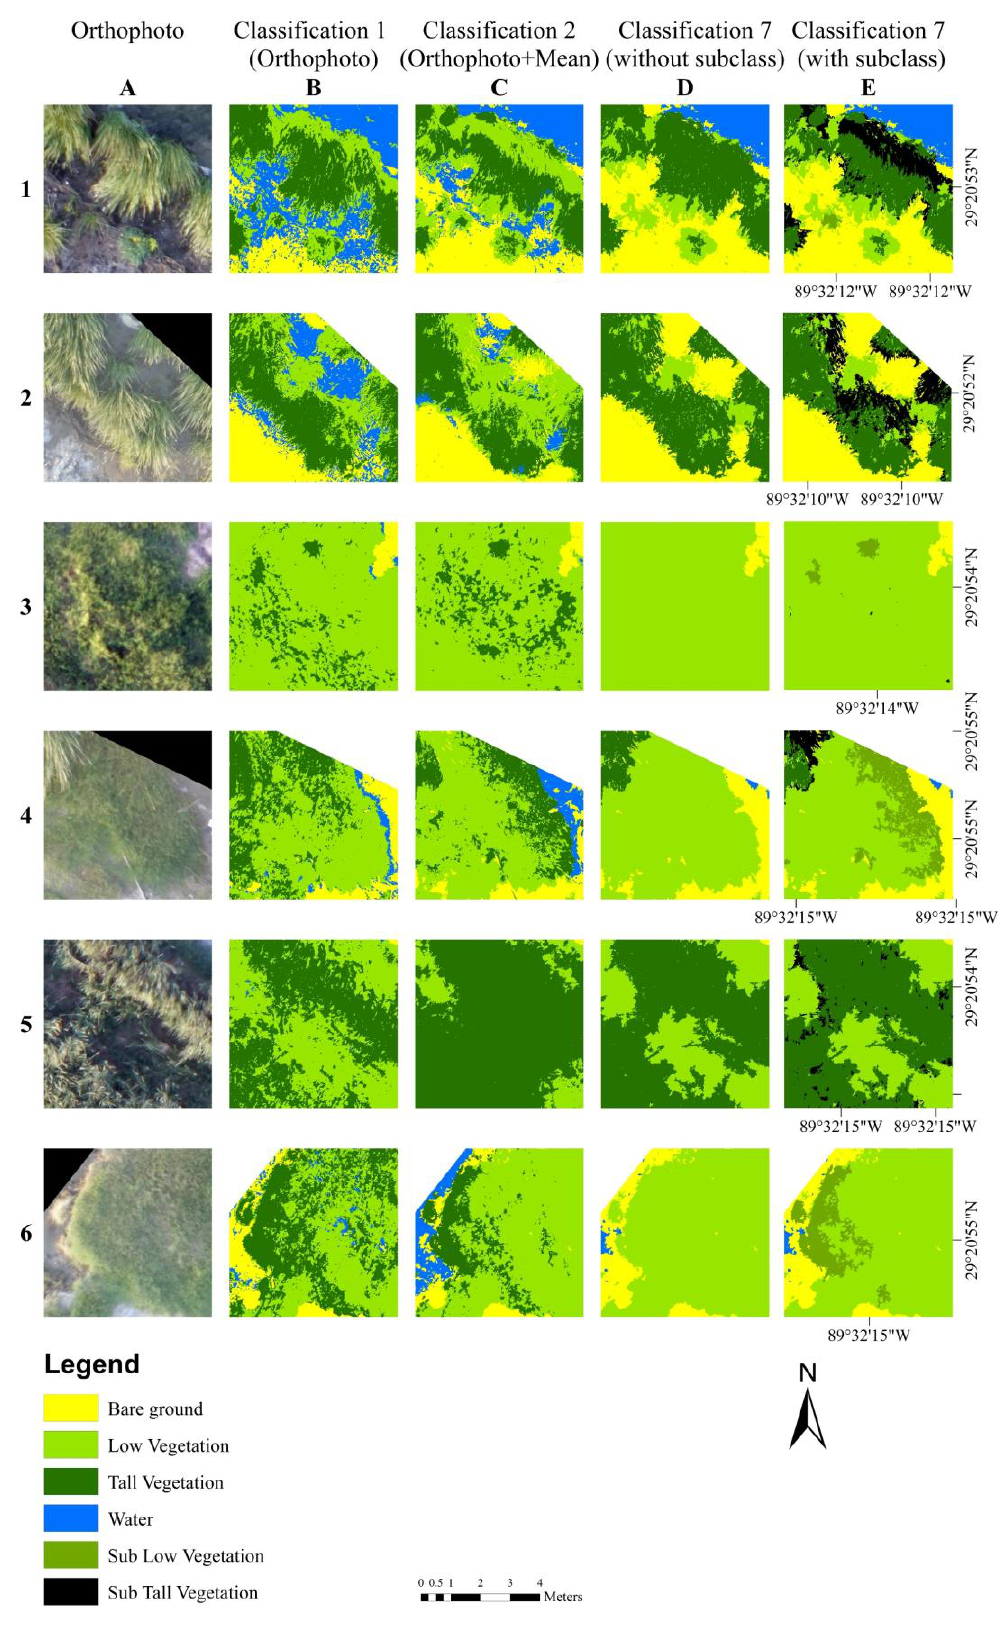
Figure 5. Representative plots for landscape scenarios and classification comparison. Classification 1 is the classification result based on orthophoto. Classification 2 is the classification result based on orthophoto and mean elevation statistic layer. Classification 7 is the classification based on the ensemble method.